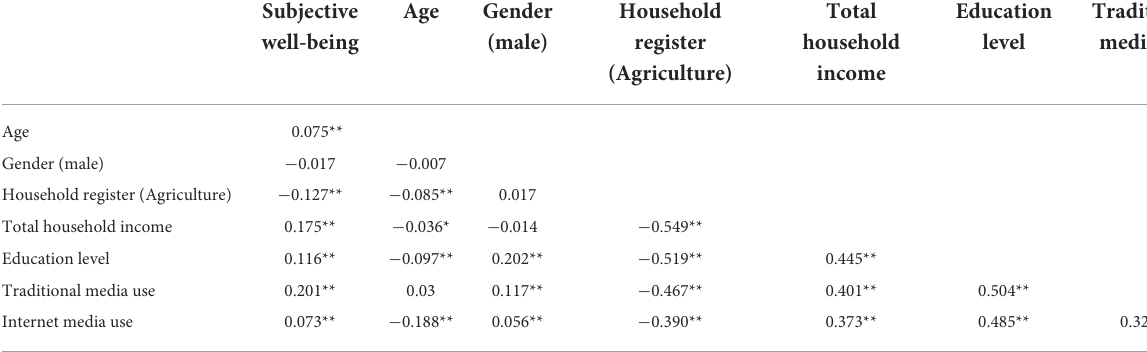
TABLE 6 Bivariate correlation between subjective well-being and other variables.